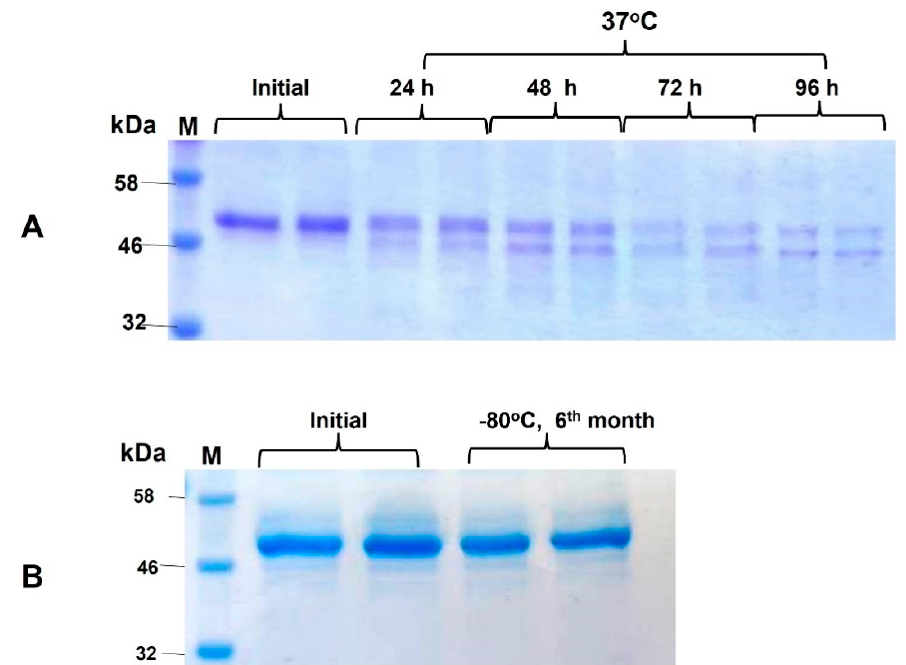
Figure 4. Stability of plant produced N protein. ( A ) Plant-produced, FLAG antibody affinity column-purified N protein was incubated at 37 ◦ C for 24, 48, 72, and 96 h, and analyzed in SDS-PAGE. Lanes were loaded with ~2.0 μ g of N protein. ( B ) Plant-produced, FLAG antibody affinity column-purified N protein was stored at − 80 °C for 6 months and then analyzed in SDS-PAGE M: color pre-stained protein standard. (Figure 4A was cropped from Figure S9 and Figure 4B was cropped from Figure S10)